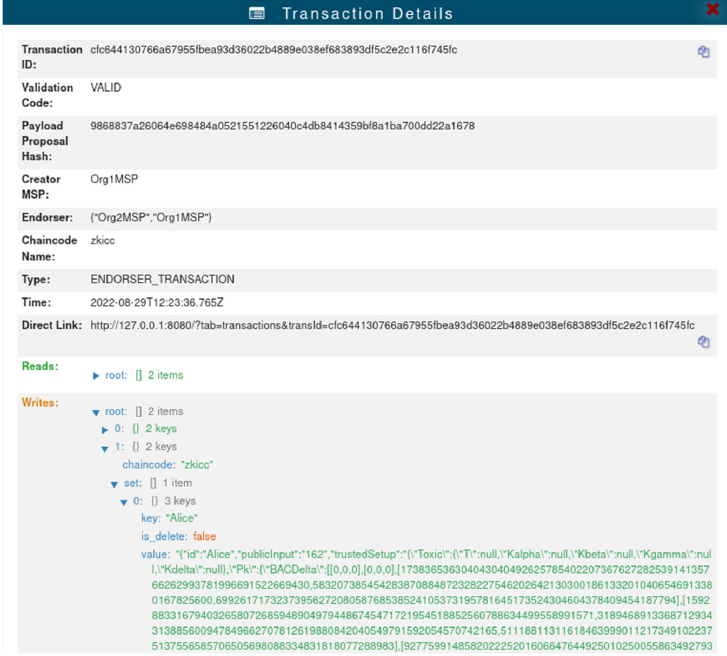
Figure 6. Register identification information.